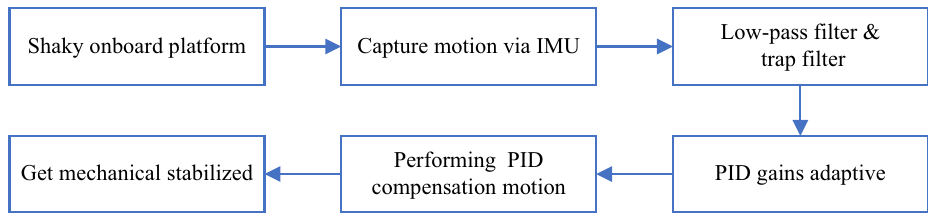
Figure 5. Detailed steps of mechanical stabilization.